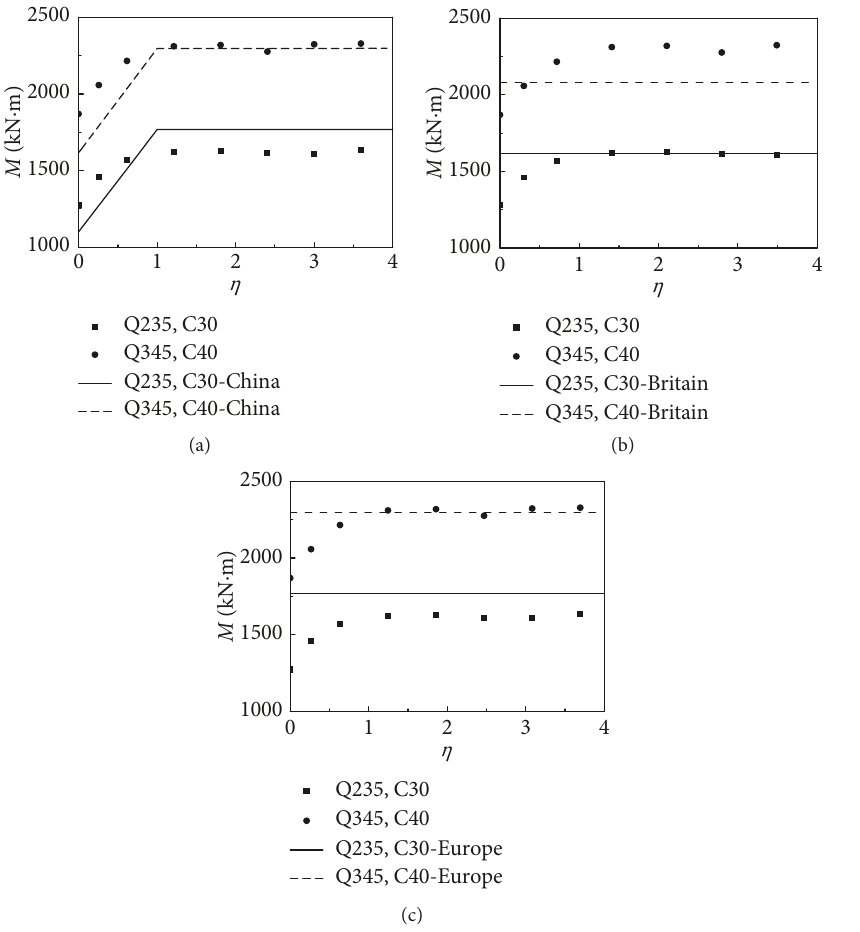
Figure 14: Influence of the double row stud layout on M - ç relationship: comparison between the results of (a) GB 50017 and FEA, (b) BS 5950 and FEA, and (c) Eurocode 4 and